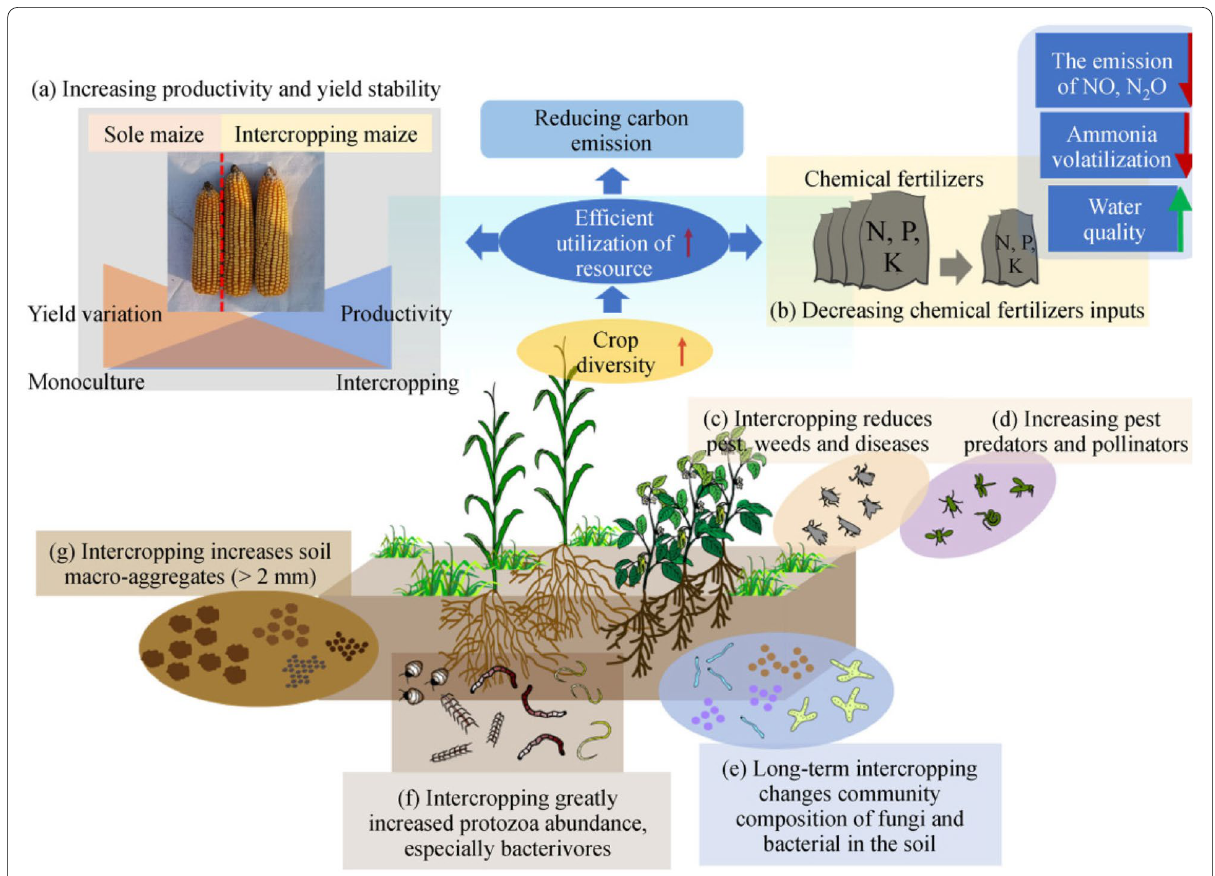
Fig. 4 Mechanism and integration of intercropping for increasing soil fertility and yield stability (adopted from (Yang et al.